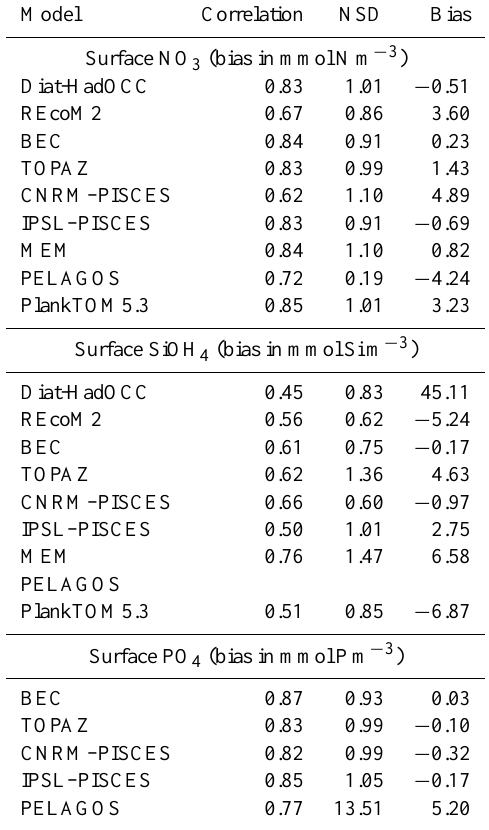
Table 6. Model skill in representing global NPP, measured in Spear- man’s rank correlation, normalized standard deviation (NSD) and bias. The NPP data are from Westberry et al. (2008); the average global NPP value is 12.6 molCm − 2 yr − 1 . The chlorophyll data are from the SeaWiFS Project; the average global chlorophyll value is 0.28mgChlm − 3 .